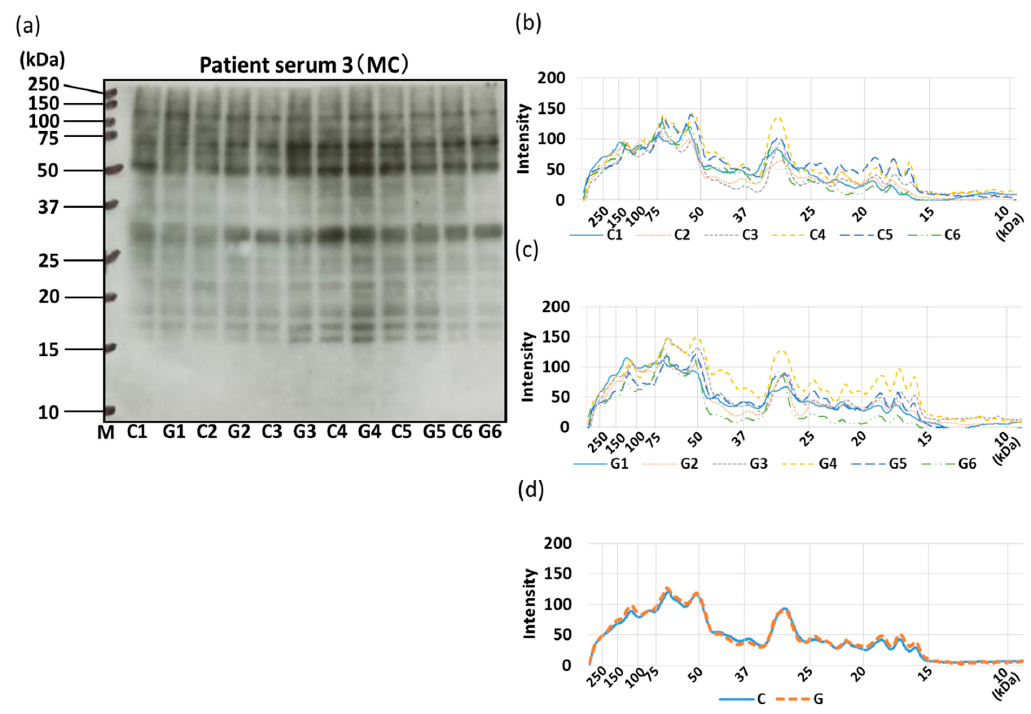
Figure 13 . IgE-immunoblotting of GM-and non-GM soybeans using patient serum 3. A representative IgE-immunoblot of GM soybeans (G1–G6) and non-GM soybeans (C1–C6) is shown (a) . Immunoblots were analyzed on each soybean sample once by densitometry and separated into non-GM soybean (b) and GM soybean groups (c) . The average IgE-immunoblot profiles of non-GM soybeans and GM soybeans were calculated (d) .